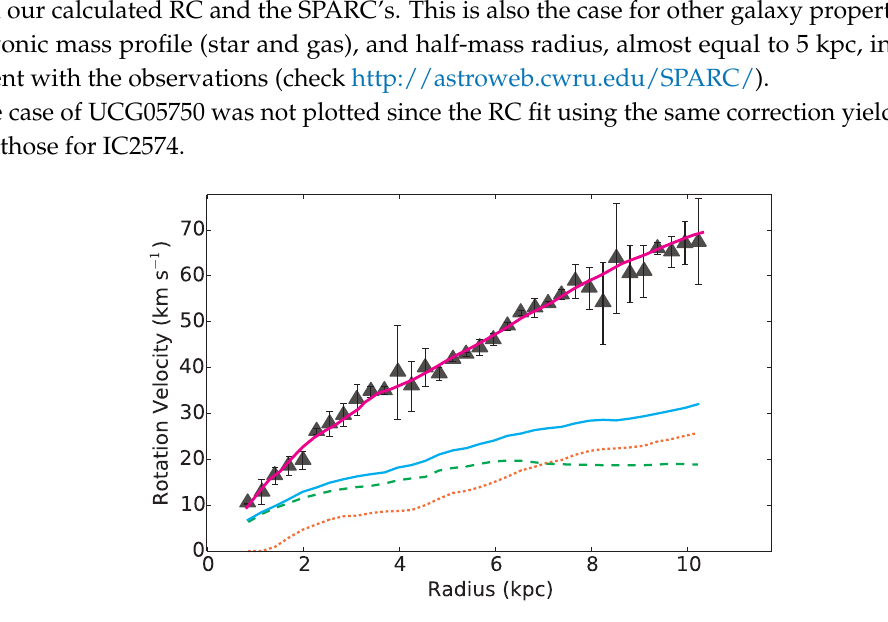
Figure 2. Rotation curve of IC2574 compared with our results. The SPARC rotation curve of IC2574 is presented as dots with error bars. Our simulations result is represented by the grey solid line, including the RCs from its stars (dotted green line) and the gas disk (dashed orange line) components, summed into the total baryonic mass (blue solid